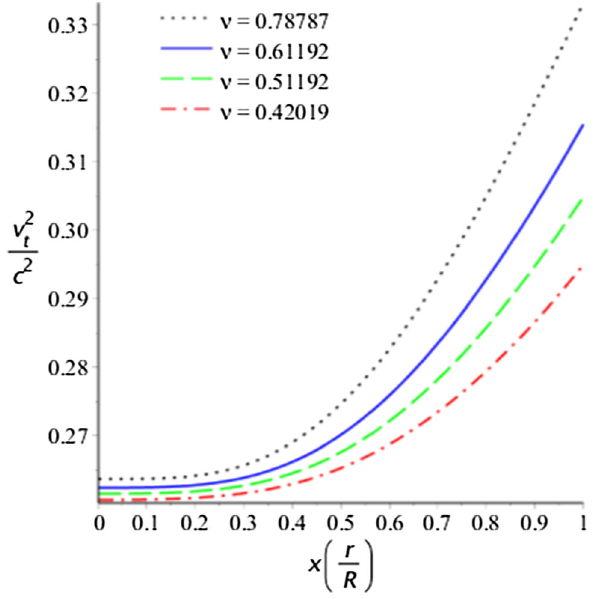
Fig. 6 Graphical representation of the tangential speed of sound for w = − 0 . 34